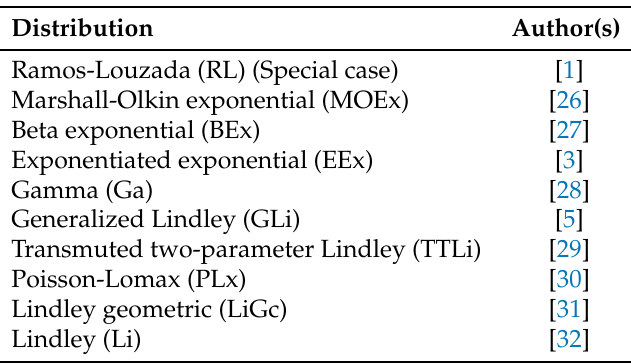
Table 11. The fitted competitive